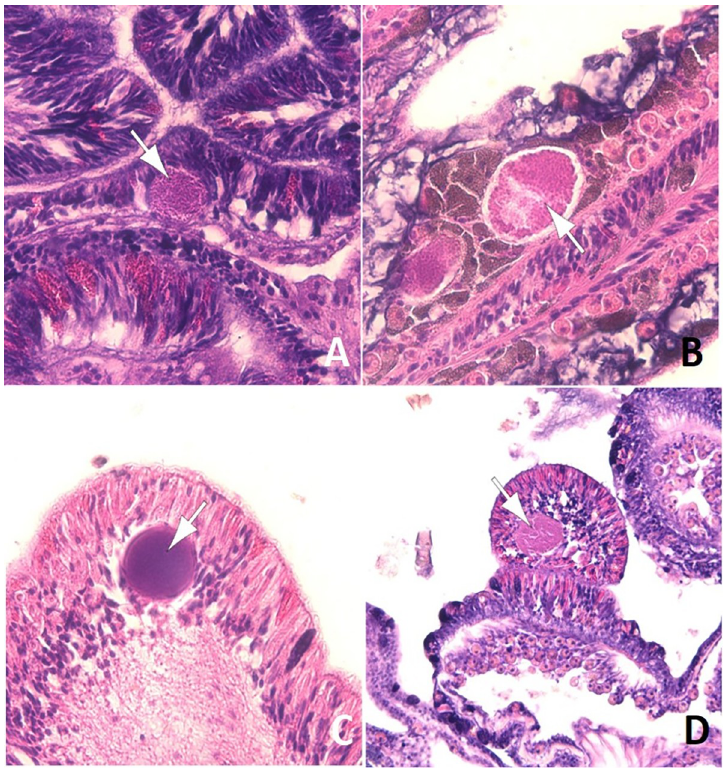
Fig 6. Cell associated microbial aggregates (arrows) in epidermis (A, C, D) and gastrodermis (B) of Stylophora (A), Porites (B), Acropora (C) and Pocillopora